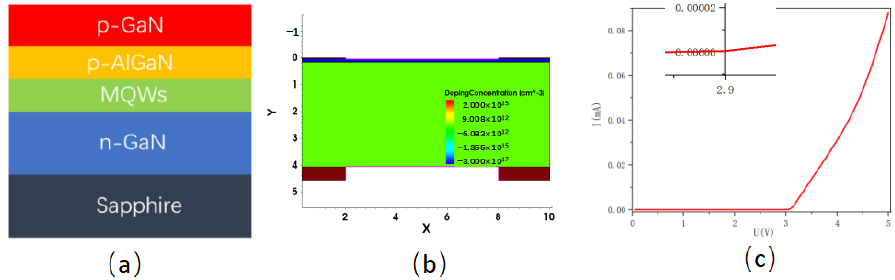
Figure 8. ( a ) Micro-LED epitaxial structure diagram. ( b ) Simulation result diagram of micro-LED